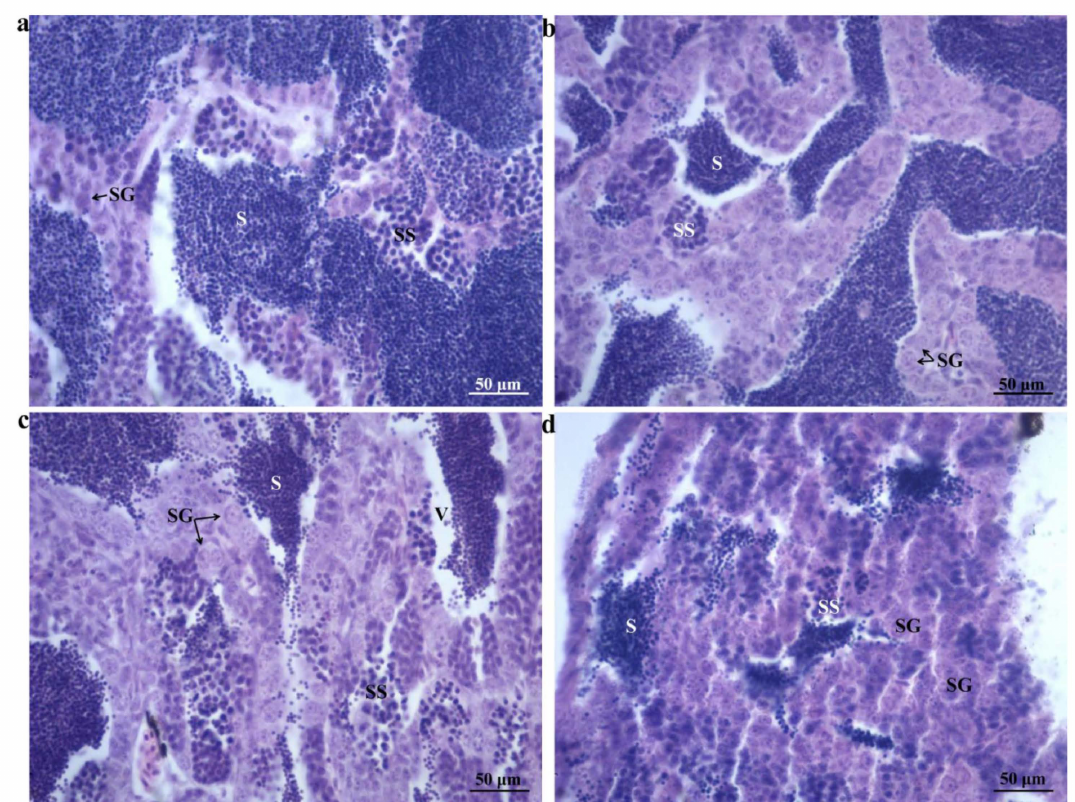
Figure 1. Photomicrographs of transverse testis sections of adult G. rarus unexposed and exposed to 17MT ( n = 6): ( a ) 7-day control group testes, ( b ) 25 ng/L 17MT for 7-day exposure, ( c ) 50 ng/L 17MT for 7-day exposure, and ( d ) 100 ng/L 17MT for 7-day exposure. H&E staining; scale bars = 50 µ